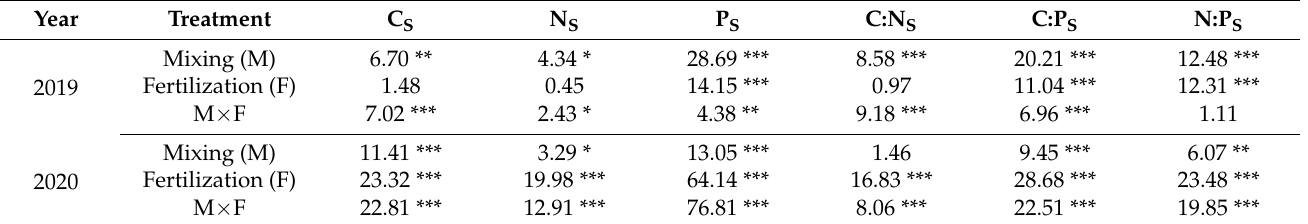
Table 5. Effects ( F value) of mixing, fertilization and their interaction on soil C, N, and P contents and stoichiometric